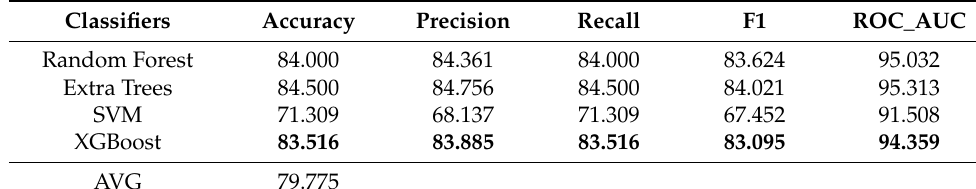
Table 12. Experimental Results using S2HT1 with 118